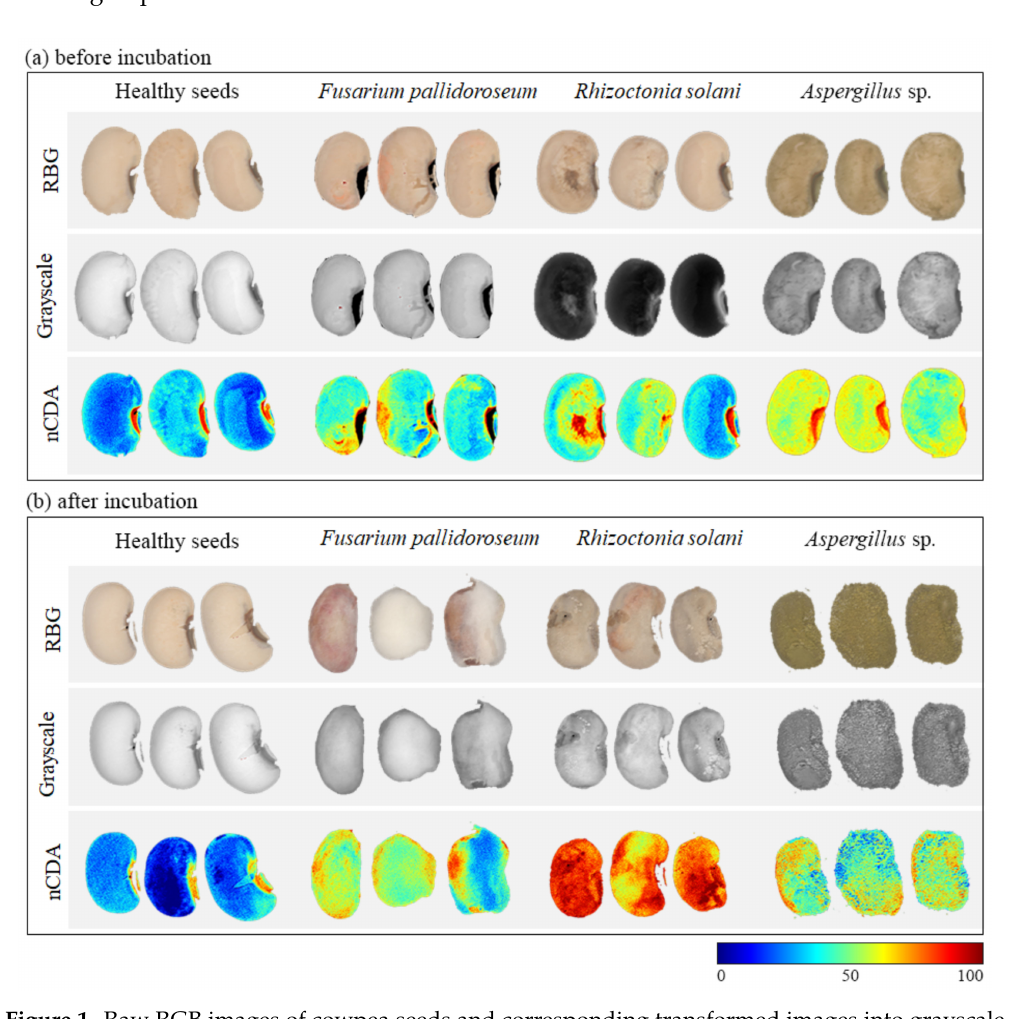
Figure 1. Raw RGB images of cowpea seeds and corresponding transformed images into grayscale and by canonical discriminant analysis (nCDA) captured at 780 nm, with reflectance patters in classes of healthy seeds, Fusarium pallidoroseum, Rhizoctonia solani and Aspergillus sp. before incubation ( a ), and after incubation ( b